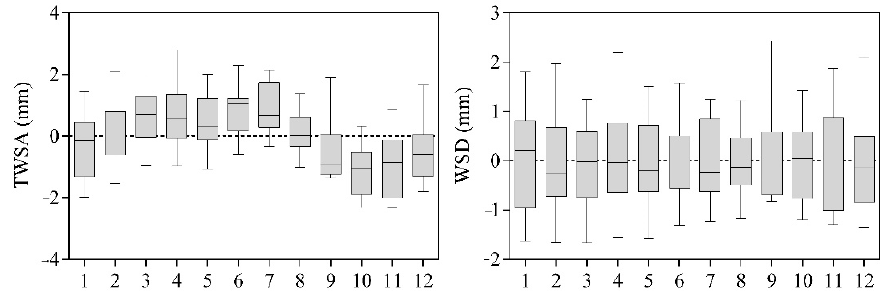
Figure 6. Box − plots showing the inter − annual change trends of total water storage anomaly (TWSA) and water storage deficit (WSD) in Mongolia from 2002 to 2017.